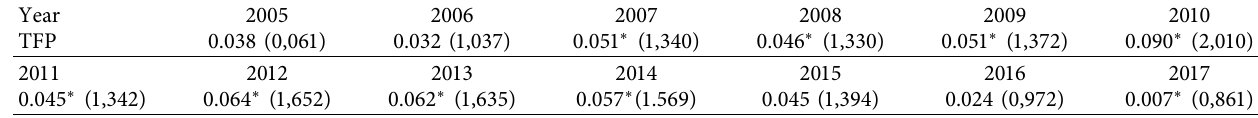
Table 4: Moran’s I index test results of high-quality economic growth index.